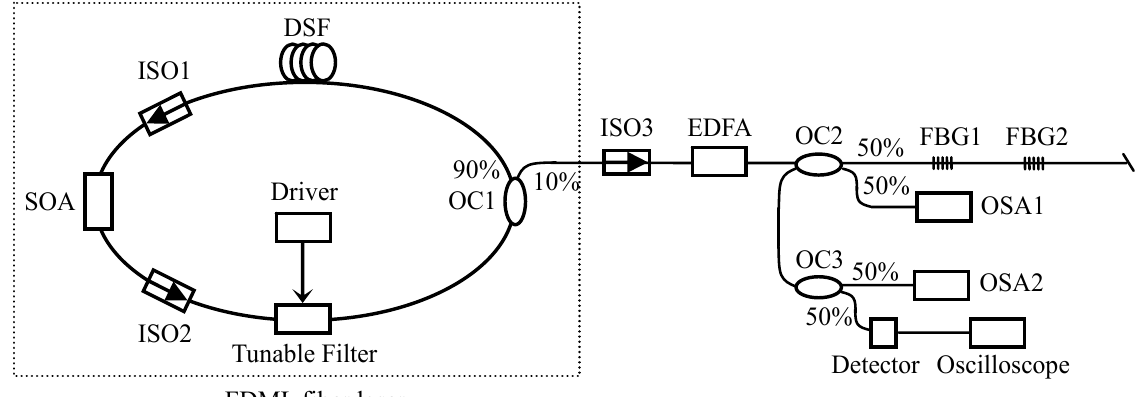
Figure 3. Experimental setup of the proposed FBG sensing system based on a FDML fiber